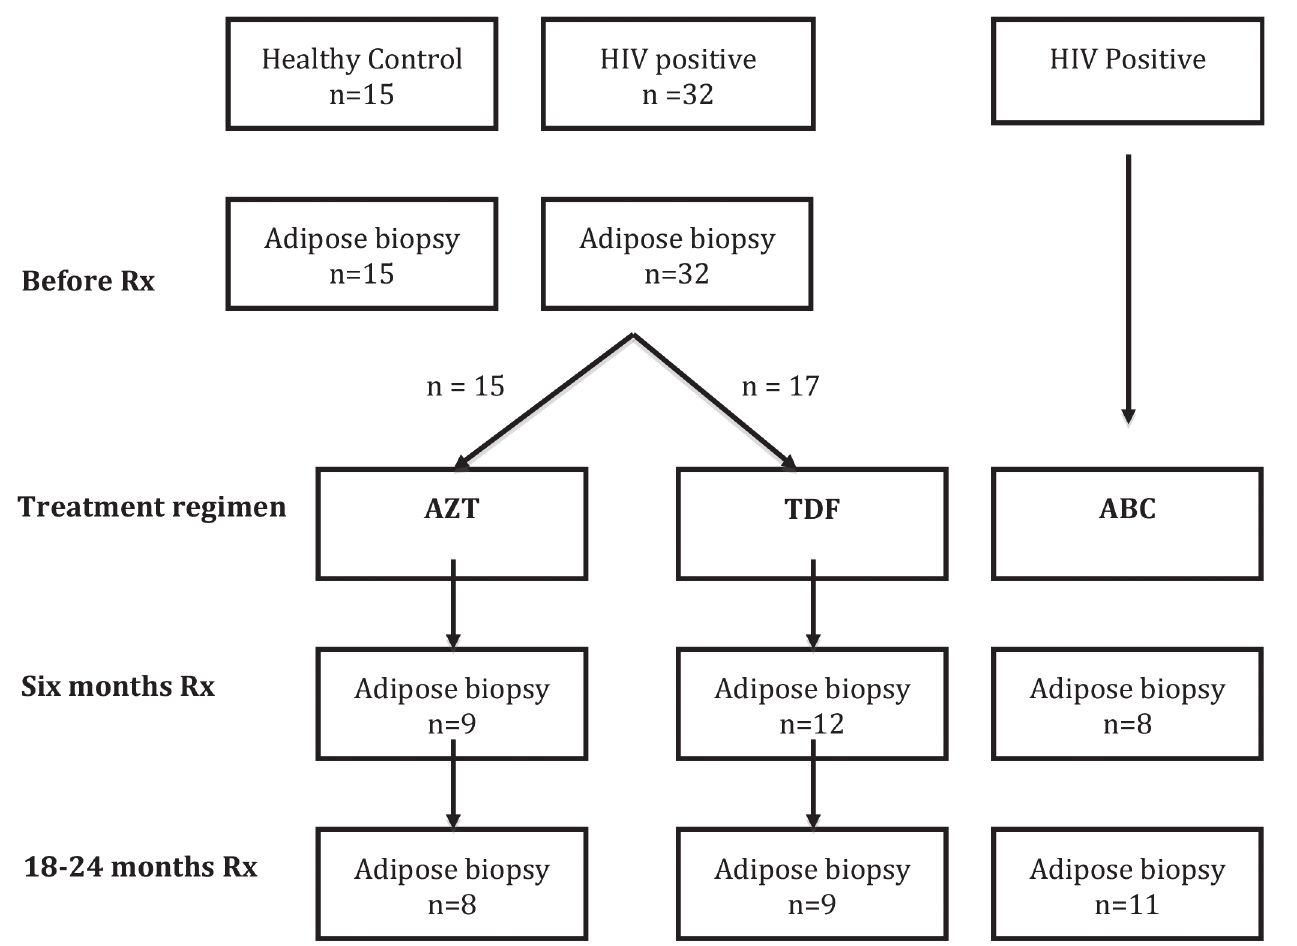
Figure 1. Flow chart of study design. Rx = treatment; AZT = zidovdine and lamivudine; TDF = tenofovir and emtricitabine; ABC = abacavir and lamivudine. All three groups were also taking efavirenz; n = number of samples available for microarray at each time